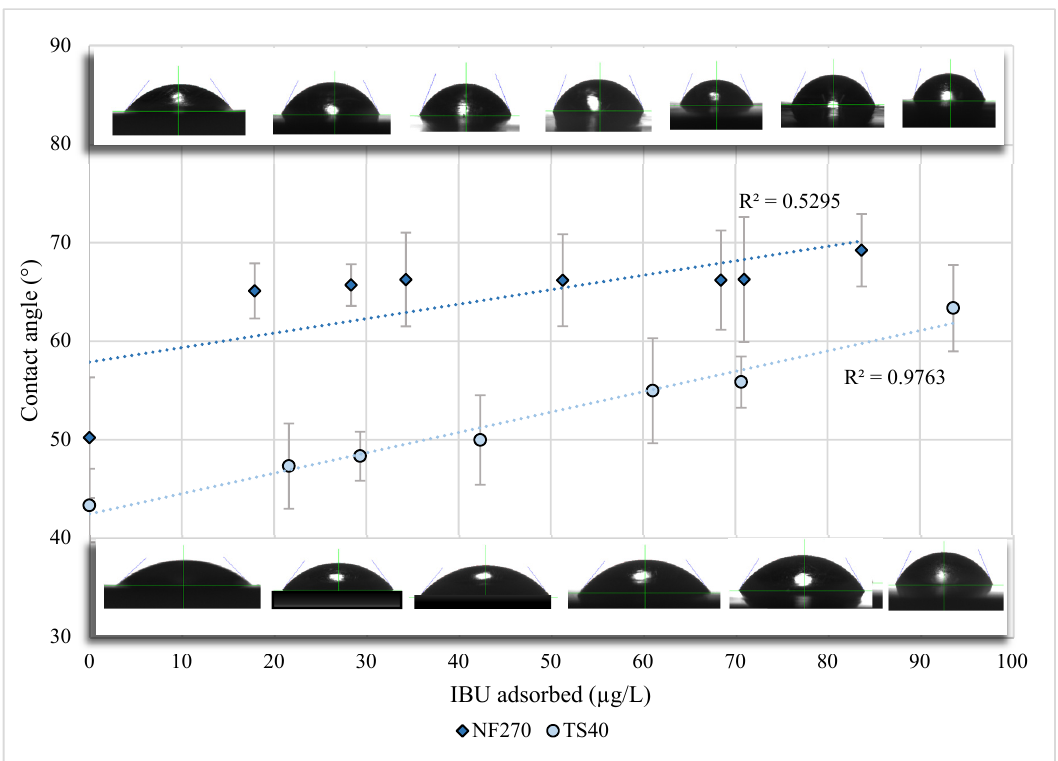
Figure 3. Contact angle of NF270 and TS40 membranes as a function of IBU adsorption. Error bars represent one standard deviation of uncertainty. Contact angle snapshots provide a visual image of the linear relationship between hydrophobicity and adsorbed IBU.